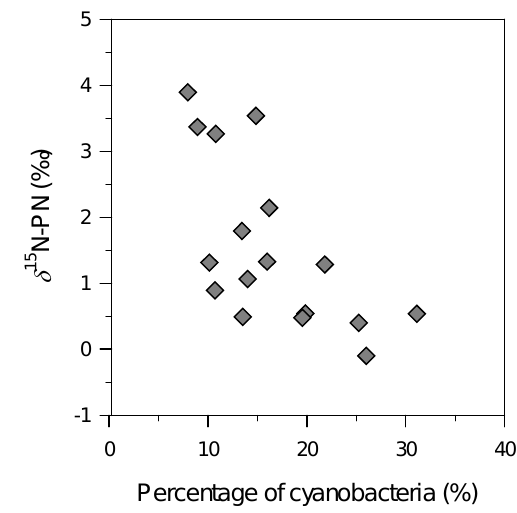
Figure 7. Relationship between the relative contribution of cyanobacteria to the phytoplankton assemblage (percentage of biomass) and the δ 15 N signature of the particulate nitrogen pool in the mixed